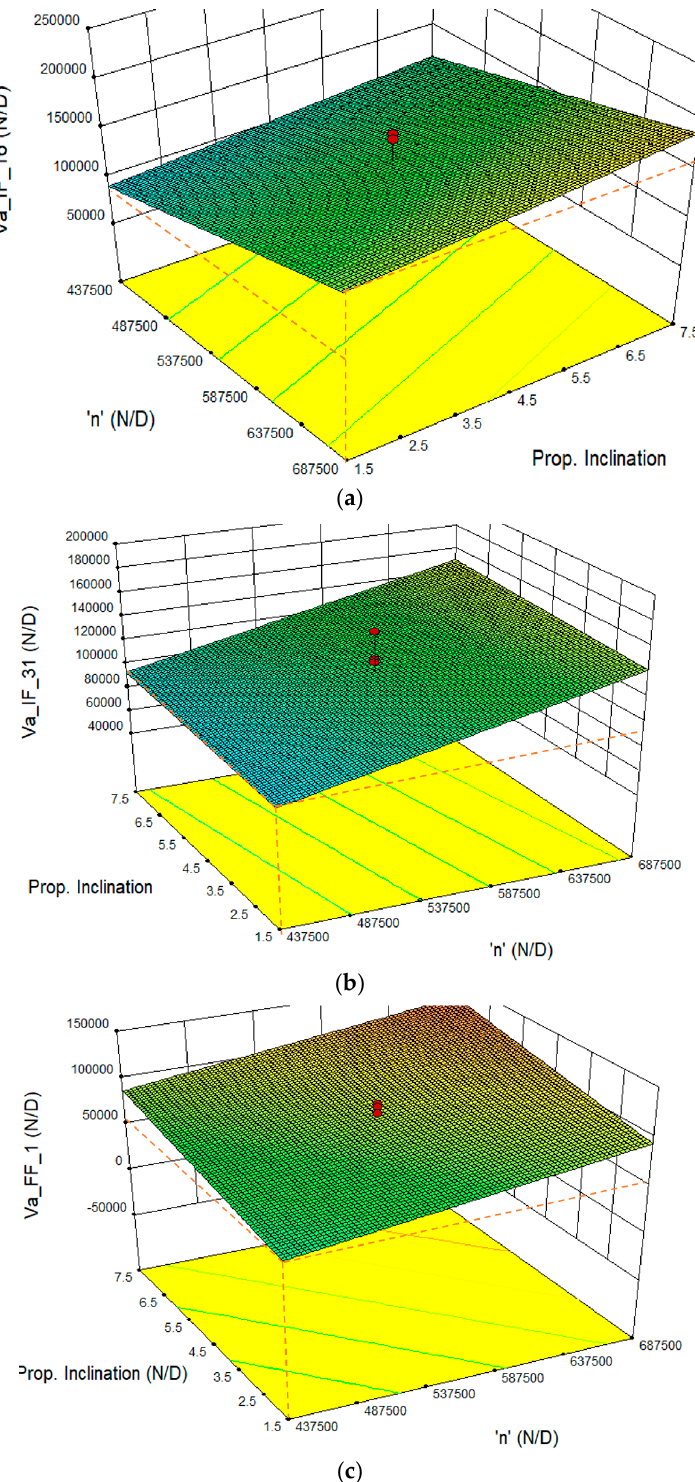
Figure 8. ( a ) 3D surface plot showing the interaction effect of ‘n’ and ‘ θ ’ on the mean axial flow velocity at the point location of (x/D p , y/D p , d/D p ) = (7.5, 0.0, 0.25); ( b ) 3D surface plot showing the interaction effect of ‘n’ and ‘ θ ’ on the mean axial flow velocity at the point location of (x/D p , y/D p , d/D p ) = (11.5, 0.0, 0.25); ( c ) 3D surface plot showing the interaction effect of ‘n’ and ‘ θ ’ on the mean axial flow velocity at the point location of (x/D p , y/D p , d/D p ) = (15.5, 0.0, 0.25).